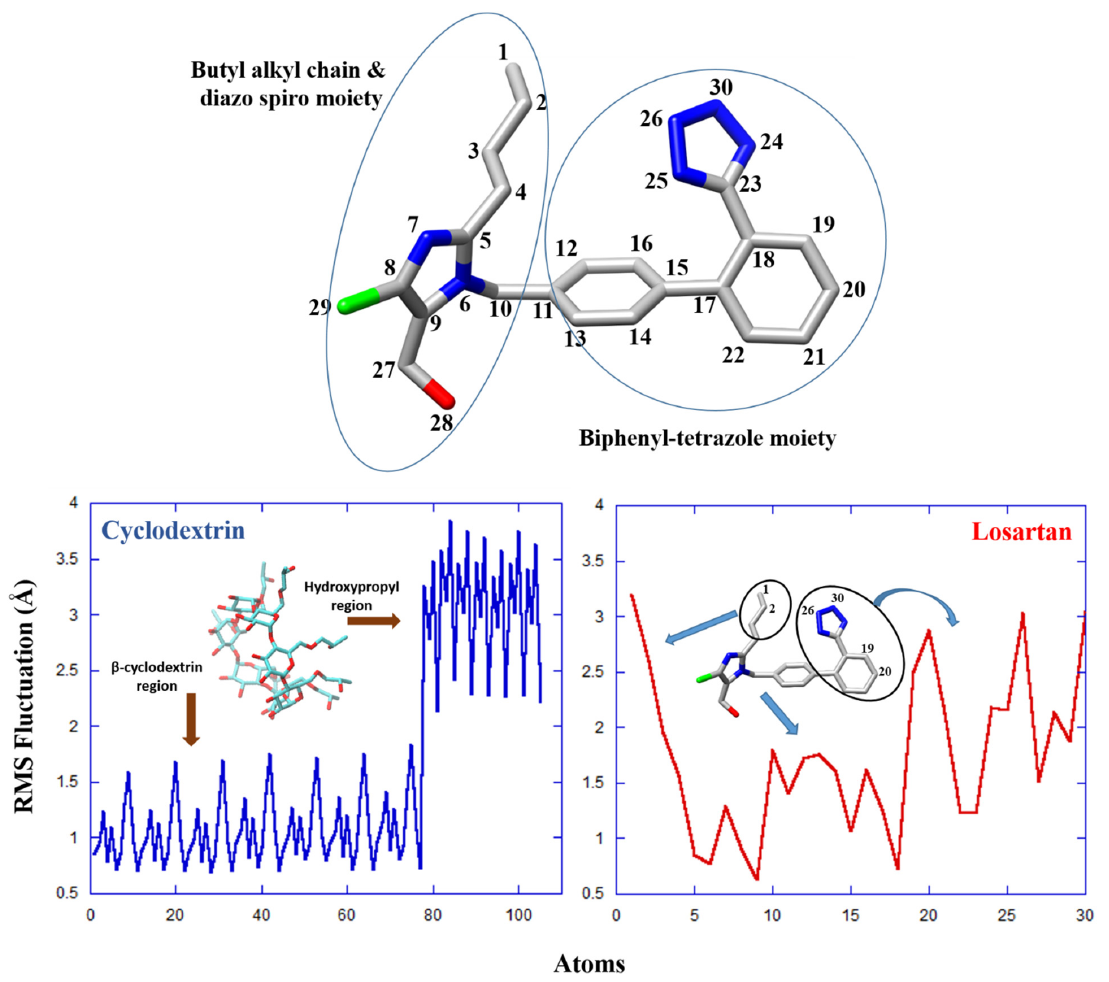
Figure 6. Chemical structure of losartan. Atoms are color coded and numbering refers to the MD calculations. RMSF values for 2-HP- β -CD (blue) and losartan (red) in the drug–cyclodextrin complex. Hydrogen atoms were omitted from the structure and from the calculations.